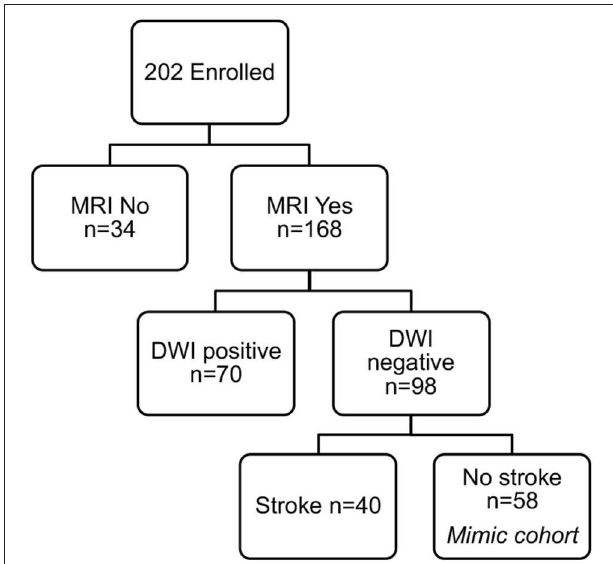
FIGURE 1 | ASPIRE Study subcohorts. The total ASPIRE Study Cohort of enrolled subjects was segmented into those with and without MRI to facilitate accurate measurement of white matter WMH burden. Individual subjects with DWI-positive scan indicating acute ischemia were excluded. Subjects with DWI-negative scans were further subdivided based on clinical diagnosis of stroke. The remaining 58 subjects presented with a neurologic mimic of stroke, did not have neuroimaging evidence of acute pathology, and were included in the analysis for plasma sphingolipid biomarkers.